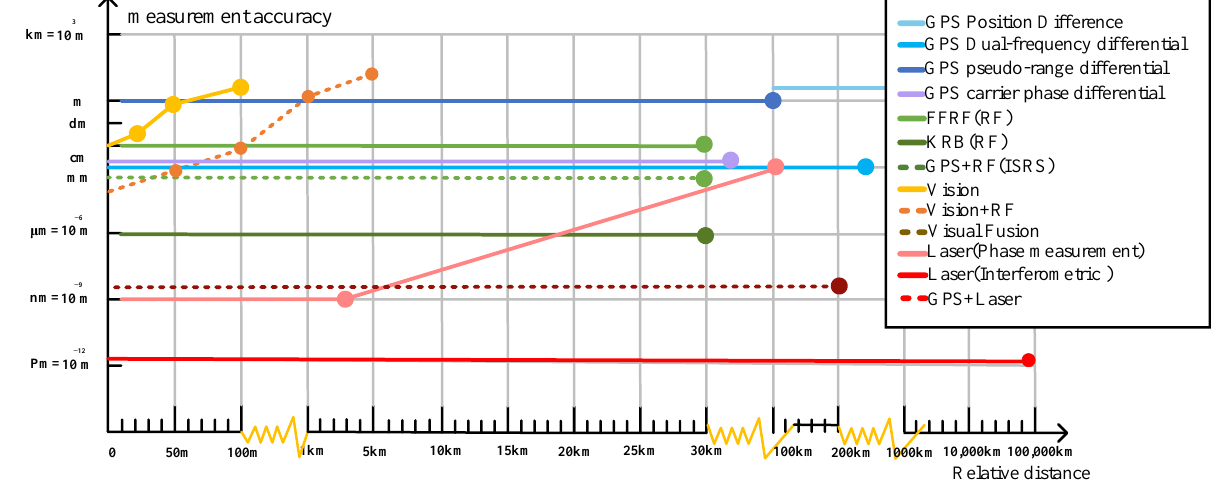
Figure 31. Accuracy comparison of the relative measurement methods.